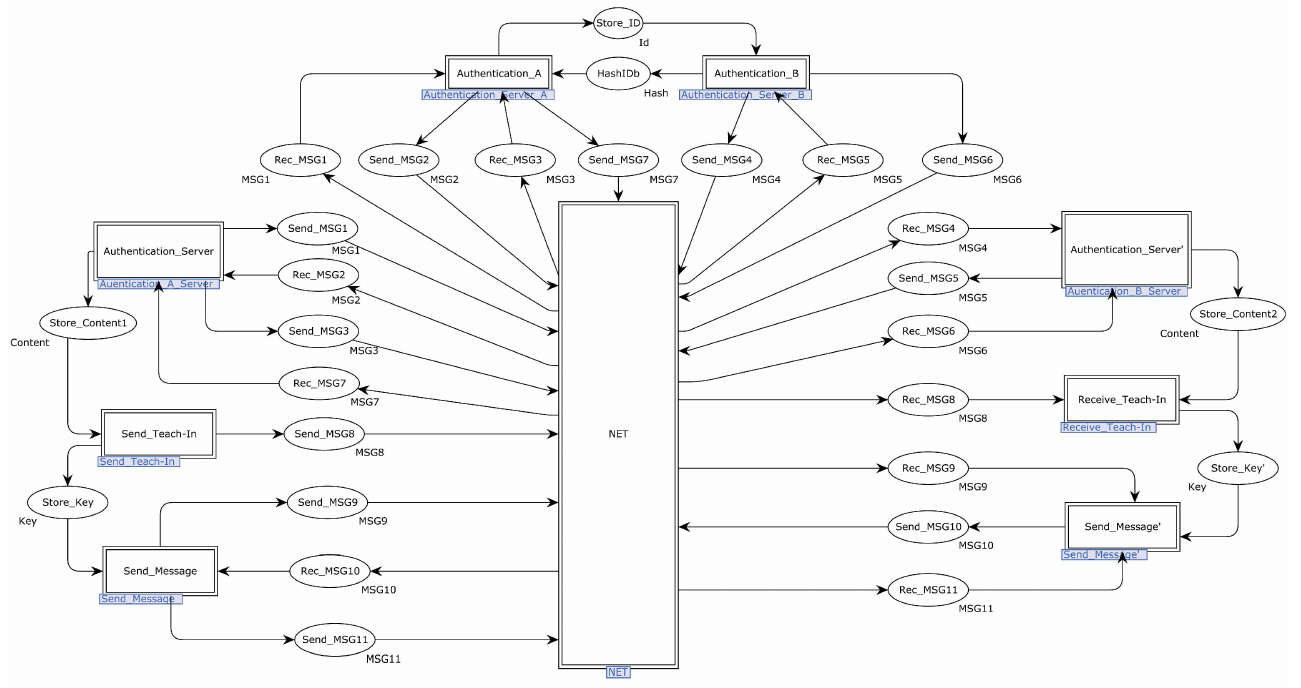
Figure 11. EnOcean-A top-level